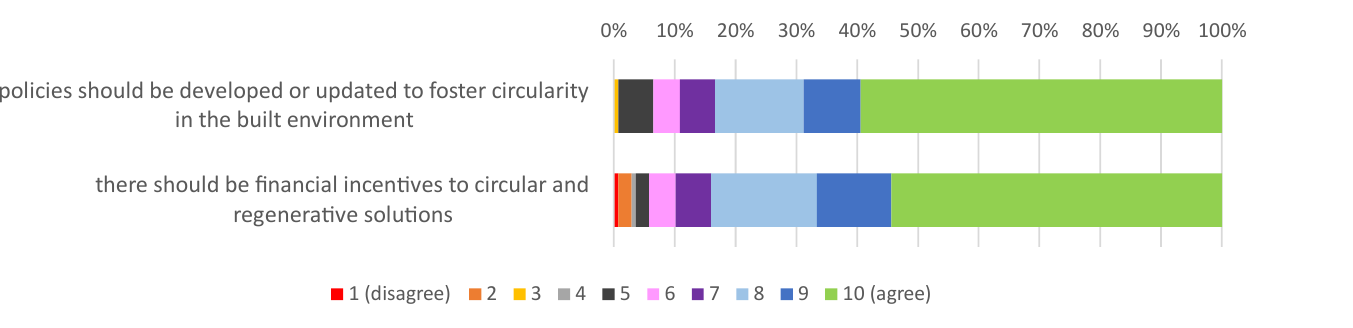
Figure 9. Perception of the need for policies and